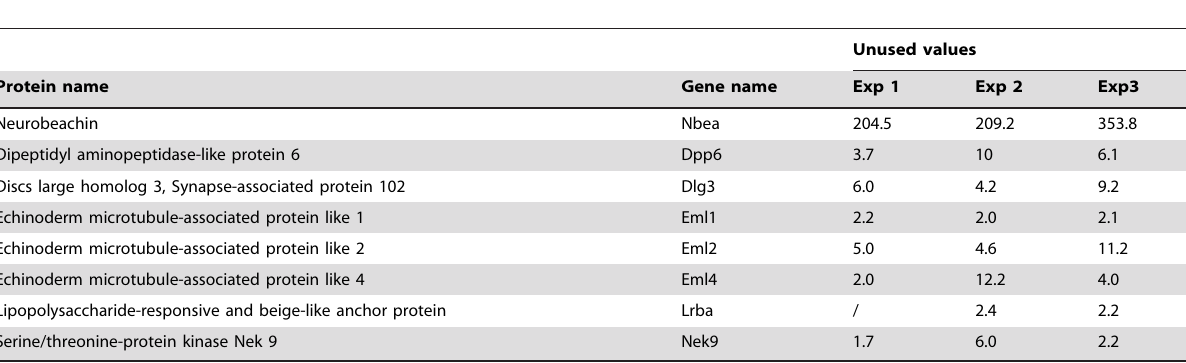
Table 2. List of proteins identified from IPs on brain homogenates of E18